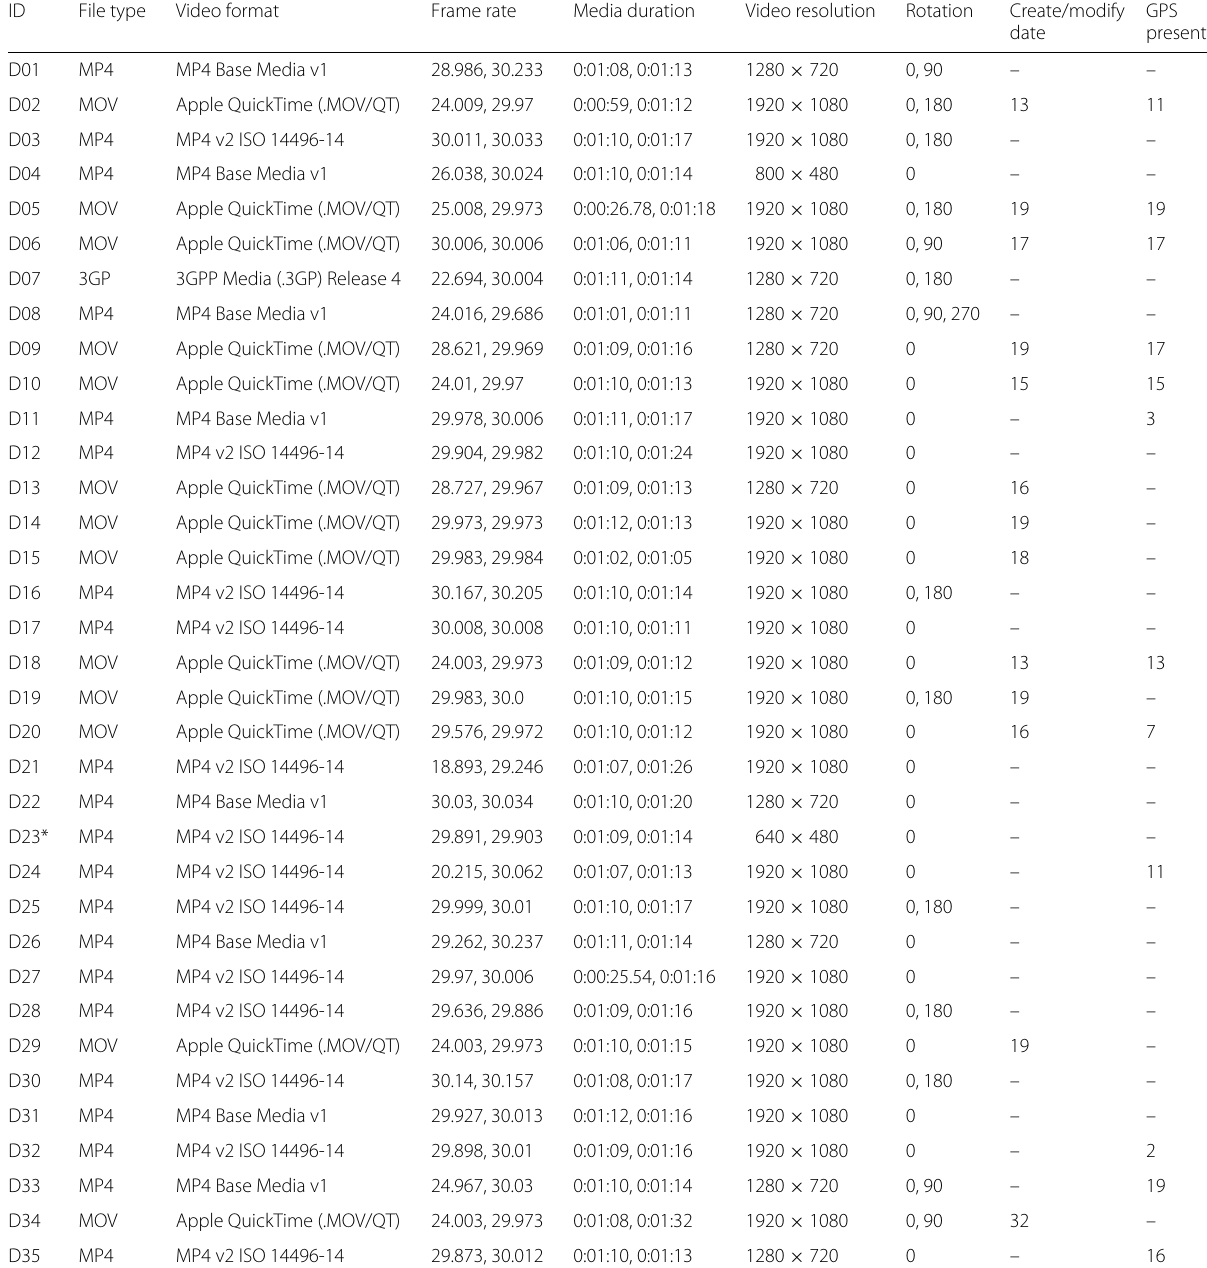
Table 7 Devices’ video characteristics in